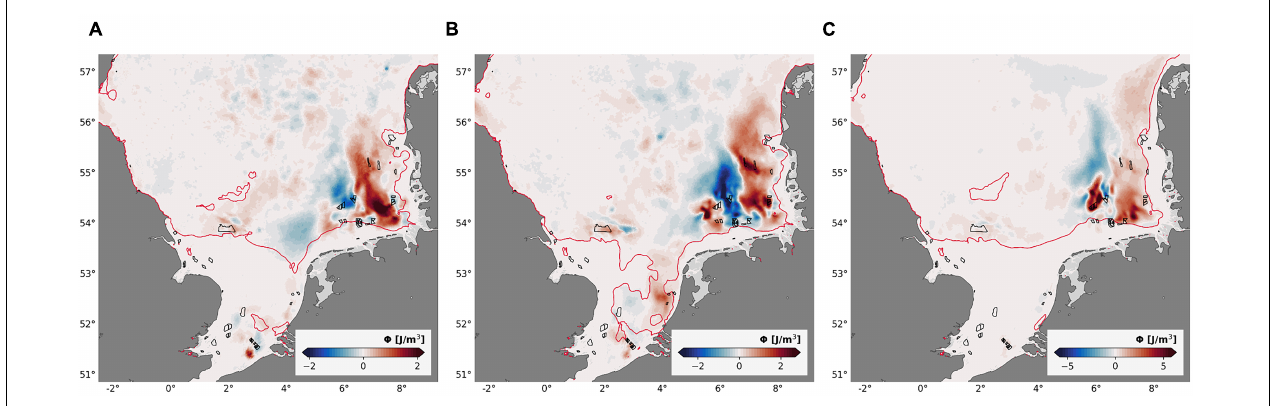
FIGURE 9 | Monthly mean changes in stratification (potential energy anomaly (cid:56) ) for the months of June (A) , July (B) , and August (C) . The red lines indicate the location of the mean tidal mixing fronts within the respective months. Black polygons indicate offshore wind farms.